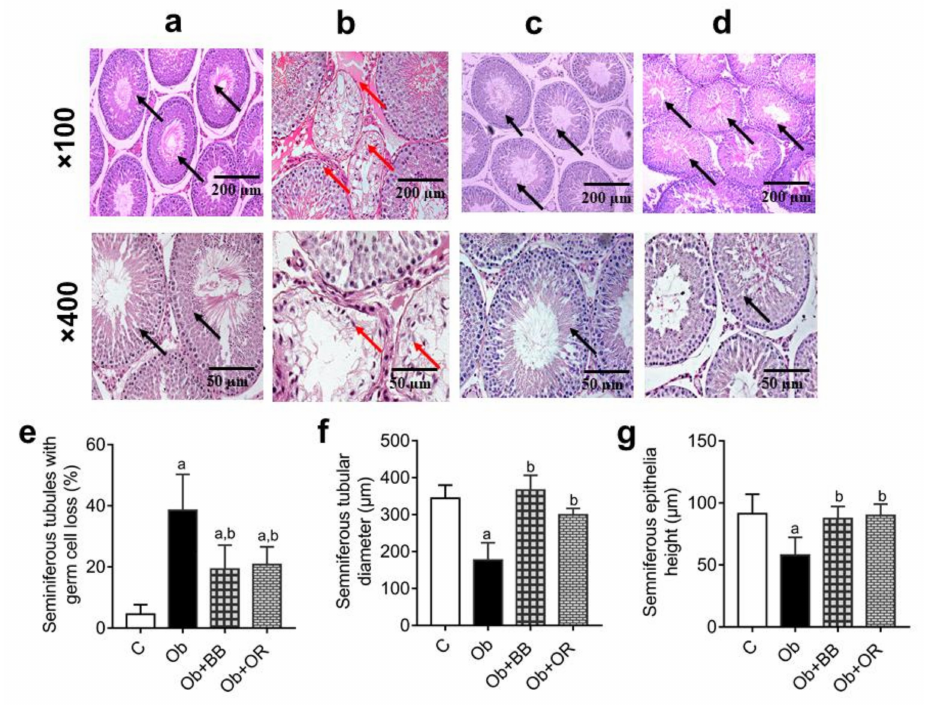
Figure 1. Representative photomicrographs of H&E staining of testes in ( a ) C, ( b ) Ob, ( c ) Ob + BB, ( d ) Ob + OR groups. C: control; Ob: obese rats; Ob + BB: obese + bee bread (6 weeks after induction of obesity); and Ob + OR: obese + orlistat (6 weeks after induction of obesity). The seminiferous tubules in the Ob group were collapsed showing decreased amount of sperm and germ cells (red arrows) compared to C, Ob + BB and Ob + OR groups ( c , d ) which showed increased amount of sperm and germ cells as well as normal size seminiferous tubules (black arrows) (magnification of panel above: × 100, scale bar = 200 µ m; magnification of panel below: × 400, scale bar = 50 µ m). ( e ) Seminiferous tubule with germ cell loss, ( f ) seminiferous tubular diameter, and ( g ) seminiferous epithelial height are quantitative data, values are mean ± SD, n = 6. a p < 0.05 vs. C, b p < 0.05 vs. Ob (one-way ANOVA followed by Tukey post-hoc